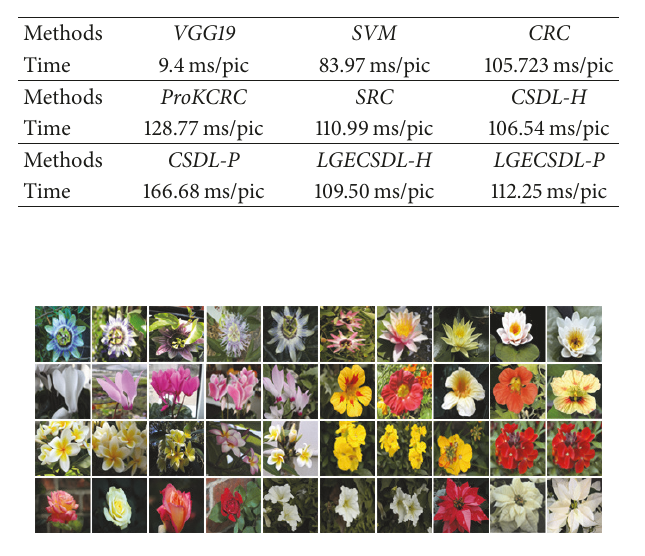
Figure 9: Examples of the Oxford-102 flower database.